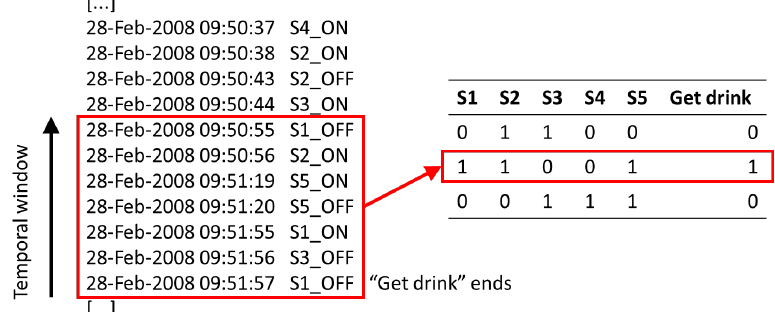
Figure 3. Example of a feature vector for a temporal window computed from the sensor data